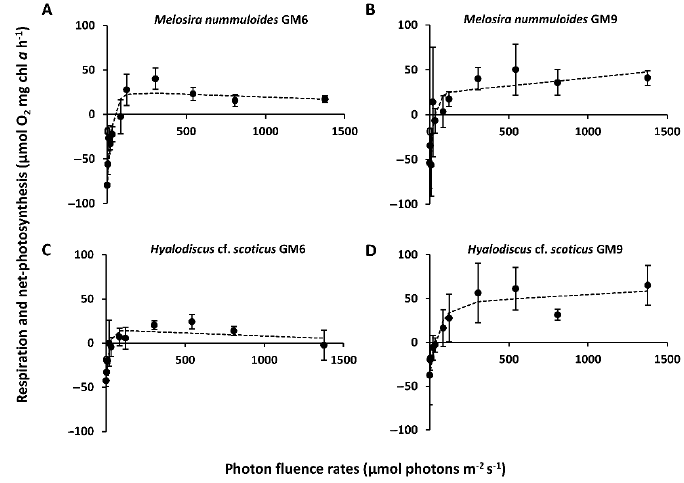
Figure 3. Photosynthesis and respiration rates ( µ mol O 2 mg − 1 chl a h − 1 ) of light curves ( µ mol